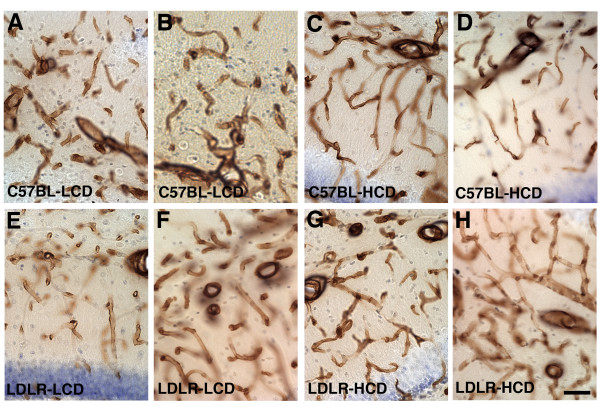
Vascular pathology in C57BL/6J and LDLR-/- mice fed a high-cholesterol diet. Anti-collagen IV immunoperoxidase-stained microvessels in the hippocampus of one-year old C57BL/6J (A-D), or LDLR-/- mice (E-H) fed low-cholesterol (A, B, E, F), or high-cholesterol (C, D, G, H) diets for 10 months. Mice in the high-cholesterol fed groups (C57BL-HCD and LDLR-HCD) exhibit a mixture of microvessels that are often thinner and irregular (see especially panels C, D) while other microvessels appear enlarged (see especially panels F, H). Scale bar = 50 μm.